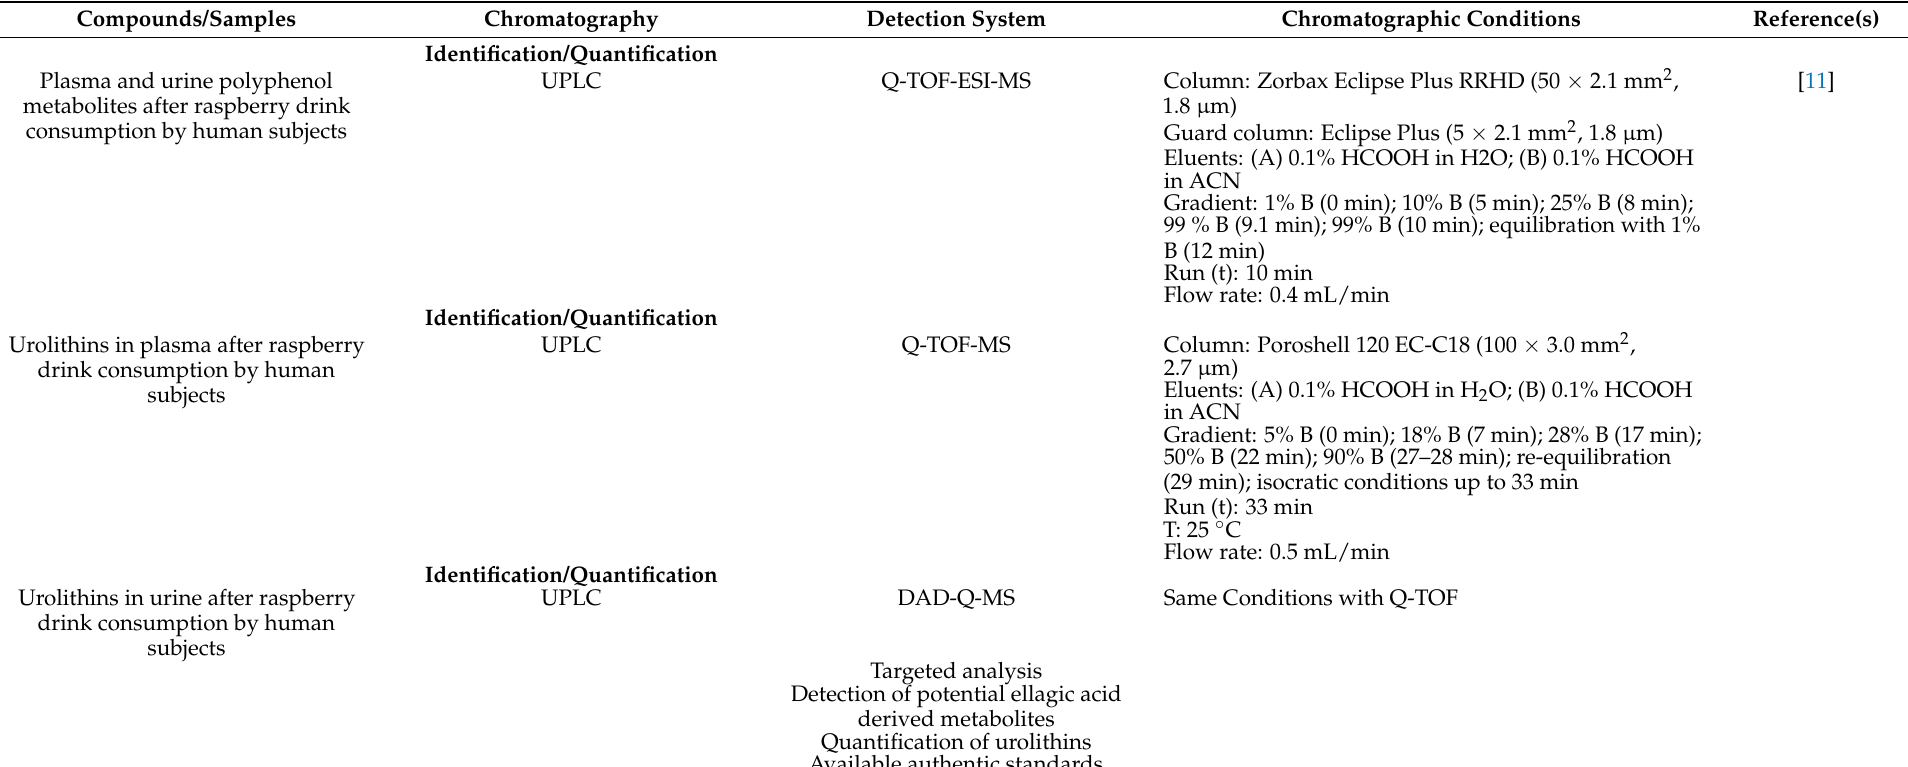
Table 2. Identification and quantification analytical techniques of ellagitannins and their metabolites in blackberries and